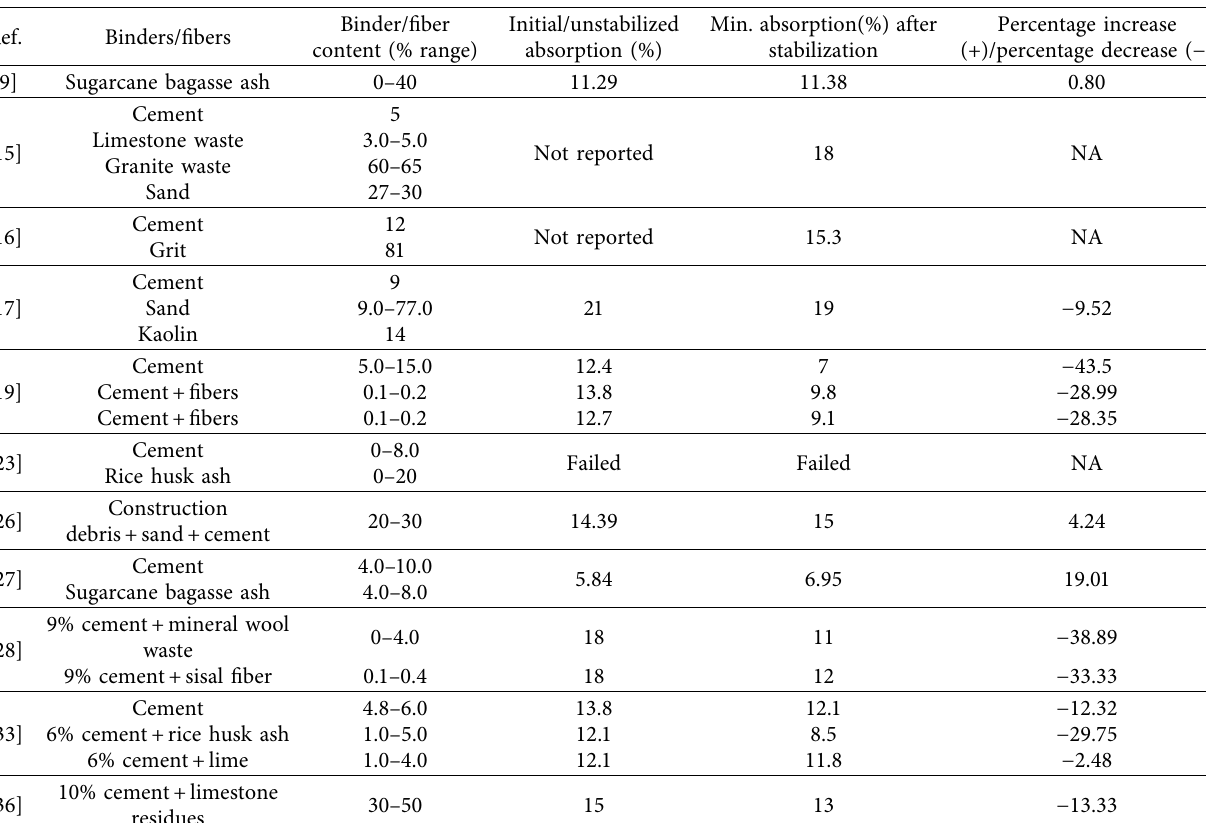
Table 8: Water Absorption values of unfired admixed soil blocks as reported in the reviewed articles.